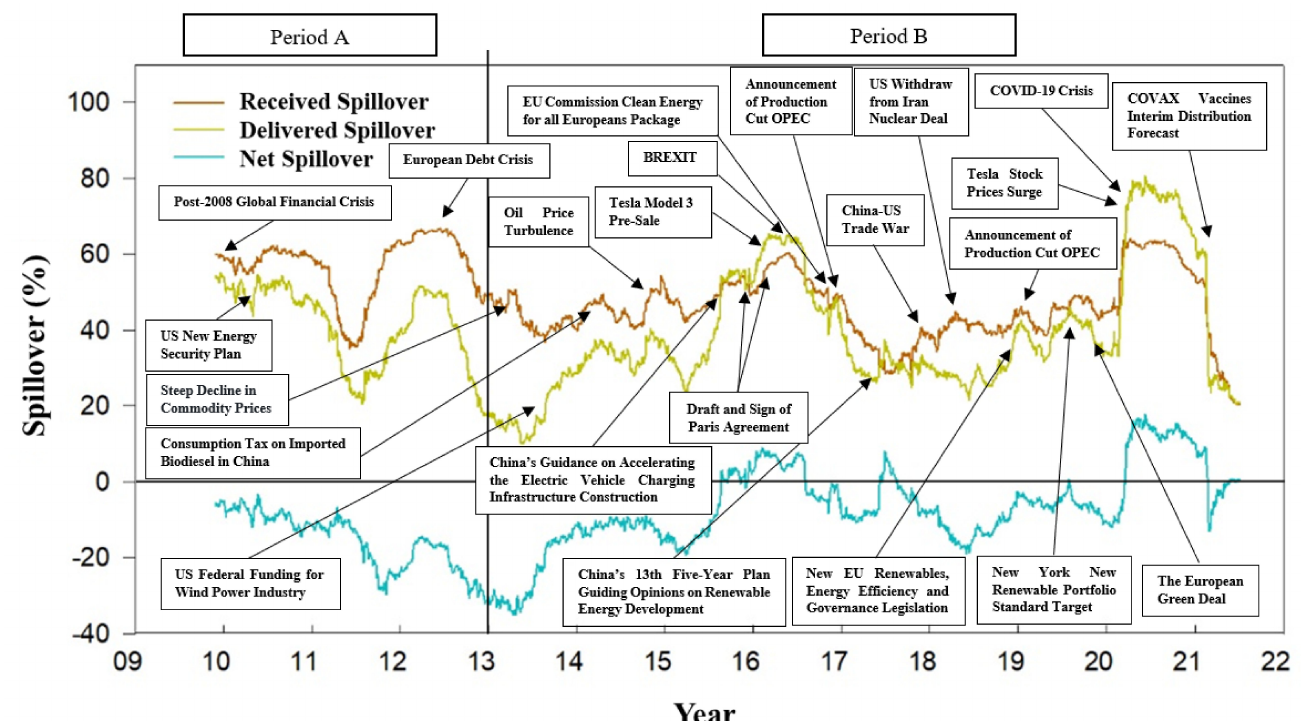
Figure 2. Spillover Plot of Received, Delivered and Net Return Spillovers of the Renewable Energy Market in the “Renewable Energy-Finance” Market System. Note: We plot the time series of the received, delivered and net return spillovers of the RE market in the “Renewable Energy-Finance” market system based on 252-day rolling samples for the period from 1 December 2009 to 8 July 2021. The underlying variance decompositions are based on VAR models with lag orders of 7, as suggested by the AIC. The forecast horizon is 5 days. In the plot, we mark the major market and political events during the studied